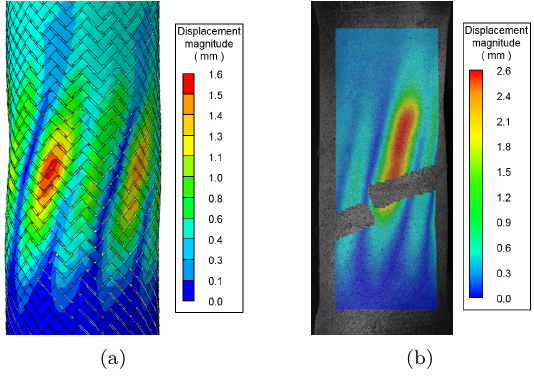
Figure 5. Buckling of the simulated structure (a) and of the tested specimen with an overlay of the DIC results (b), at a rotation angle of 0.65 ◦